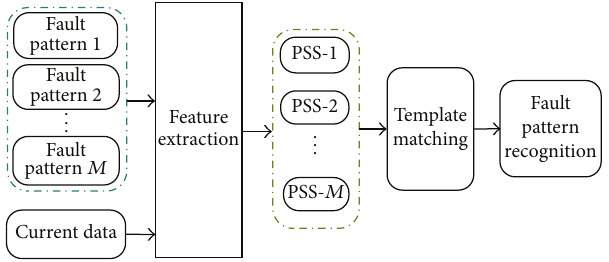
Figure 2: Framework of the fault pattern